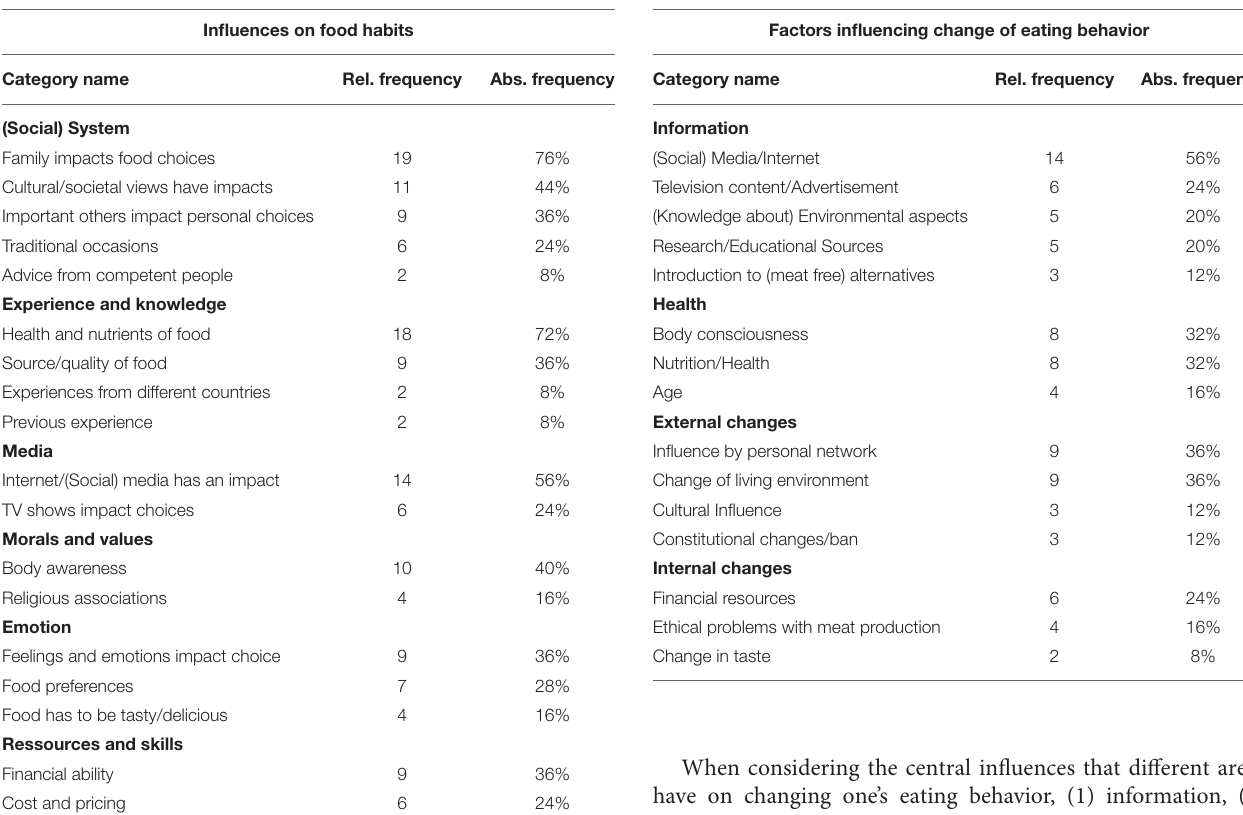
TABLE 3 | Factors influencing a change in eating habits found in 25 guideline-based interviews (inductive category system; categories with single occurrence are not mentioned in the category